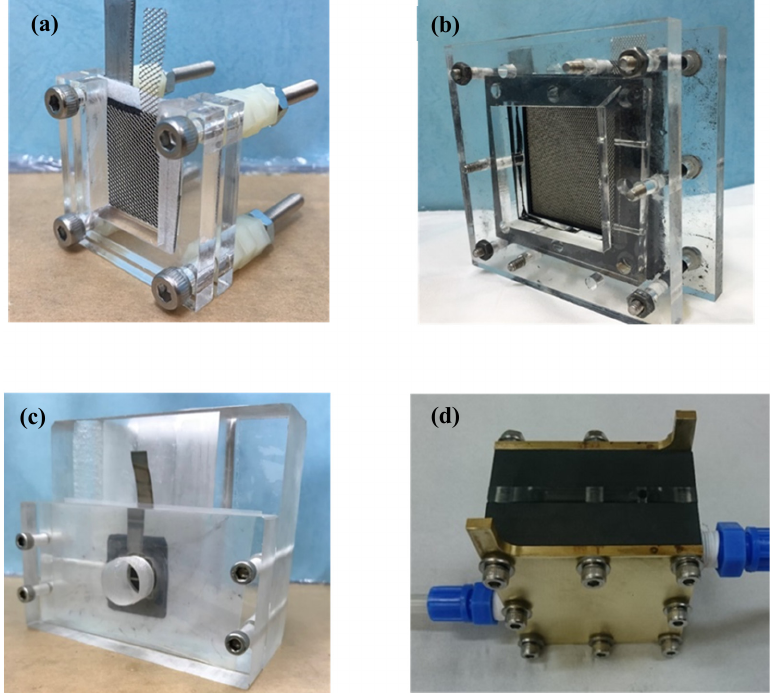
Figure 3. The four types of cells used in this study. ( a ) Cell 1: Close-proximity electrode; ( b ) Cell 2: Equal-area electrode; ( c ) Cell 3: Cell from Taipower with large zinc electrode; and ( d ) Cell 4: Air channel flow.